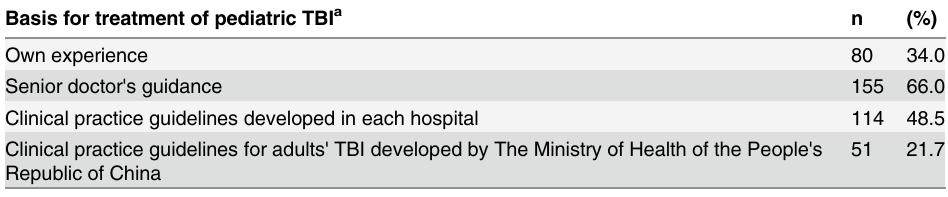
Table 5. Routine Basis for Treatment of Pediatric TBI Reported by Surveyed Clinicians in China. Basis for treatment of pediatric TBI